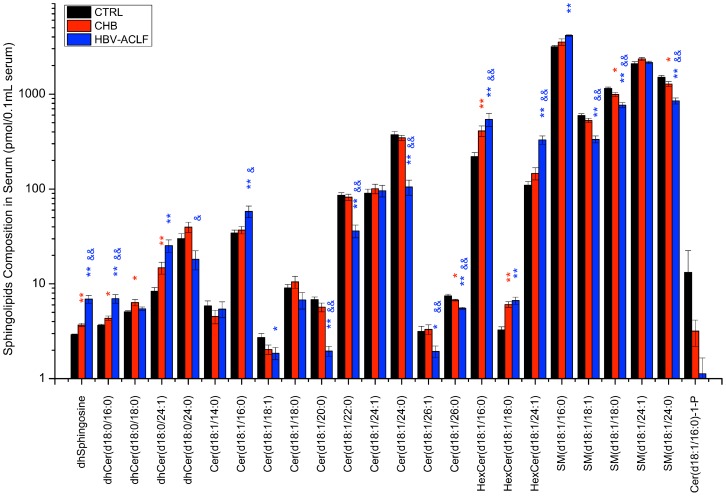
Serum sphingolipid levels in the training cohort (healthy controls, chronic hepatitis patients, and HBV-ACLF patients).Data are expressed as the mean ± SEM. *, significant difference compared with healthy controls (*  = p<0.05, **  = p<0.01); &, significant difference compared with CHB (&  = p<0.05, &&  = p<0.01).